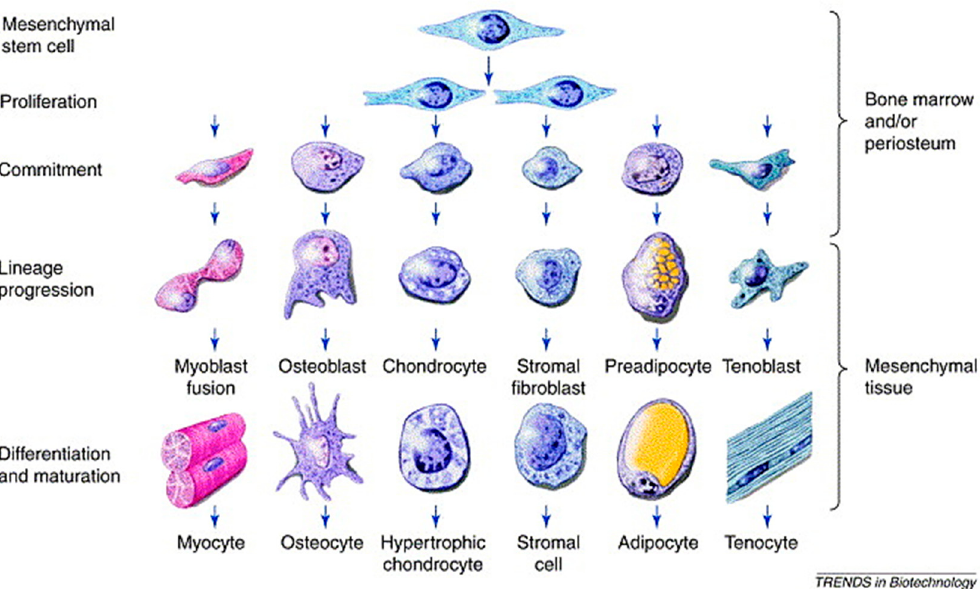
Figure 5. Schematic of the mesengenic process showing MSCs upstream and their differentiation capacity across diverse mesoderm tissues, including bone. Reprinted with permission from [61], under Elsevier and Copyright Clearance Center (license number 5166410951759).